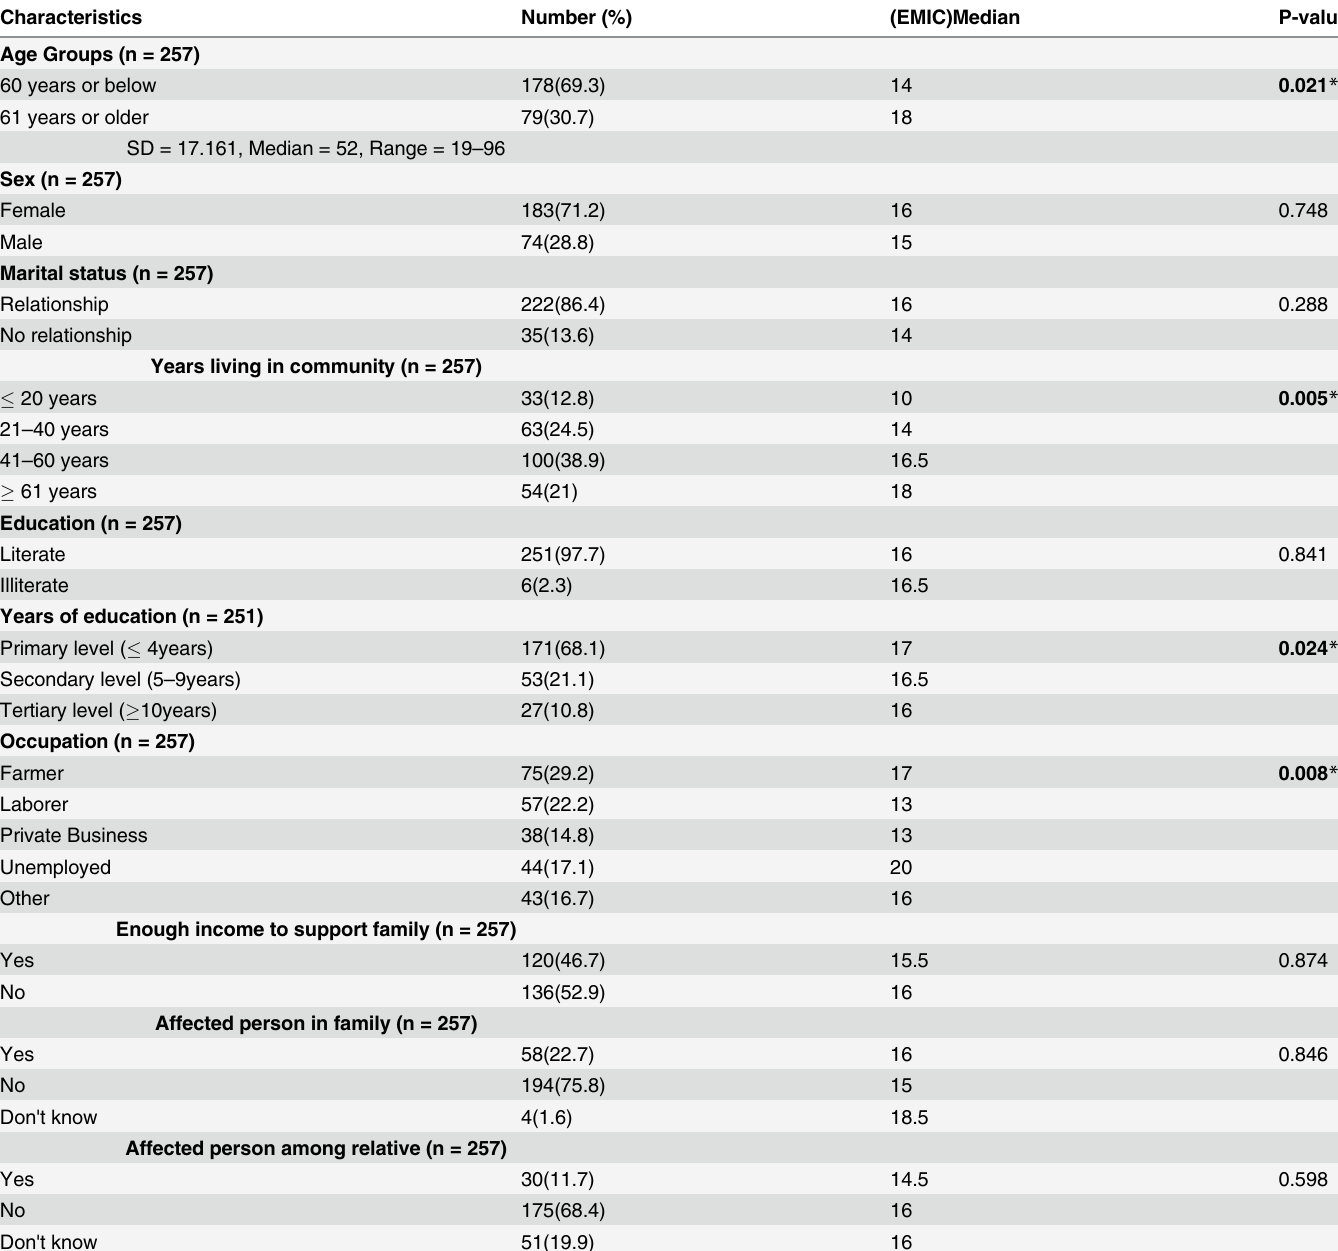
Table 1. Socio-demographic characteristics of unaffected participants and EMIC score (n =